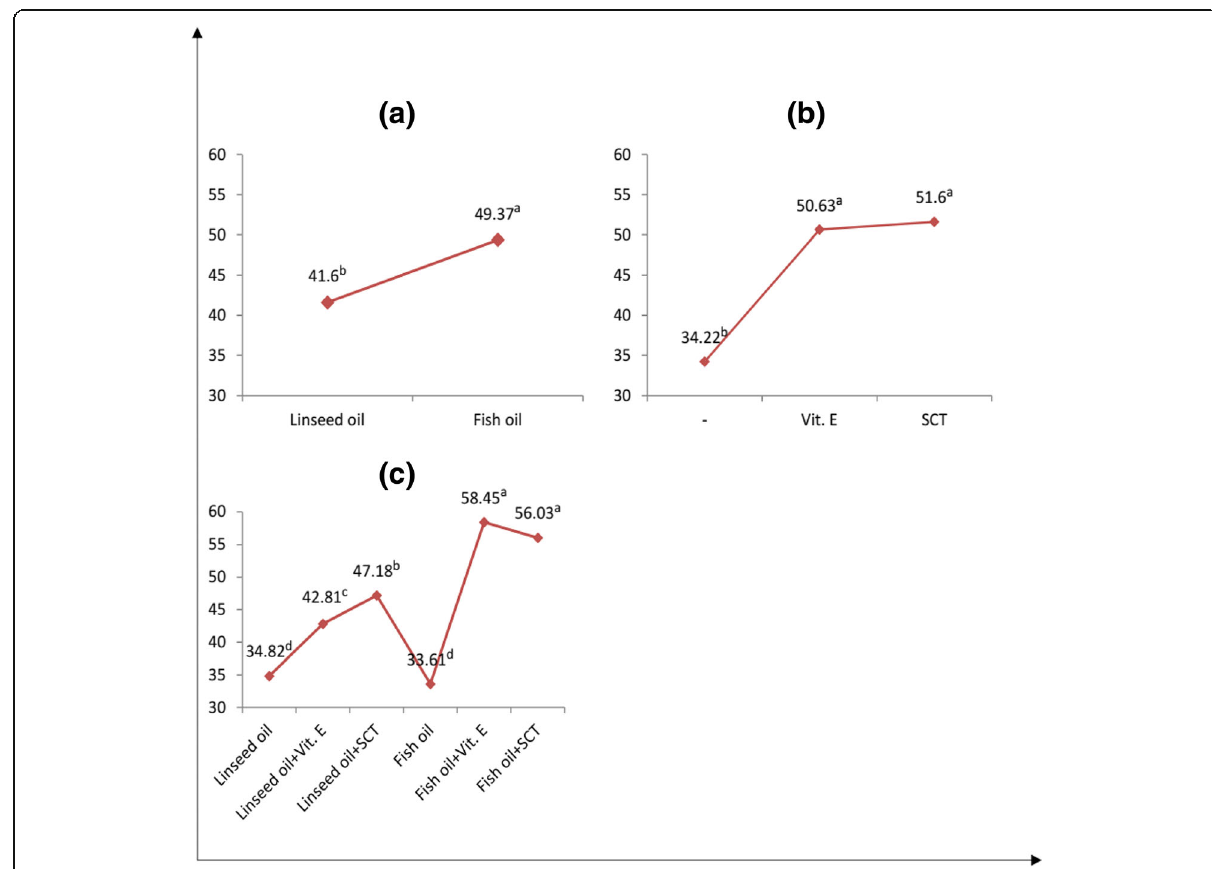
Fig. 2 1,1-Diphenyl-2-picrylhydrazyl value of meat of broilers fed diets containing different sources of oils and antioxidants. a Oil sources, b antioxidant sources, c interaction between oil and antioxidant sources. Superscript letters a and b indicate means within rows with no common superscripts differ significantly ( P <